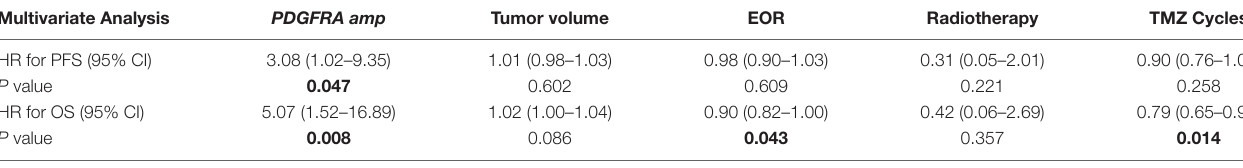
TABLE 6 | Influence of PDGFRAamp-mut on prognosis of ccGBM by multivariate cox regression. Multivariate Analysis